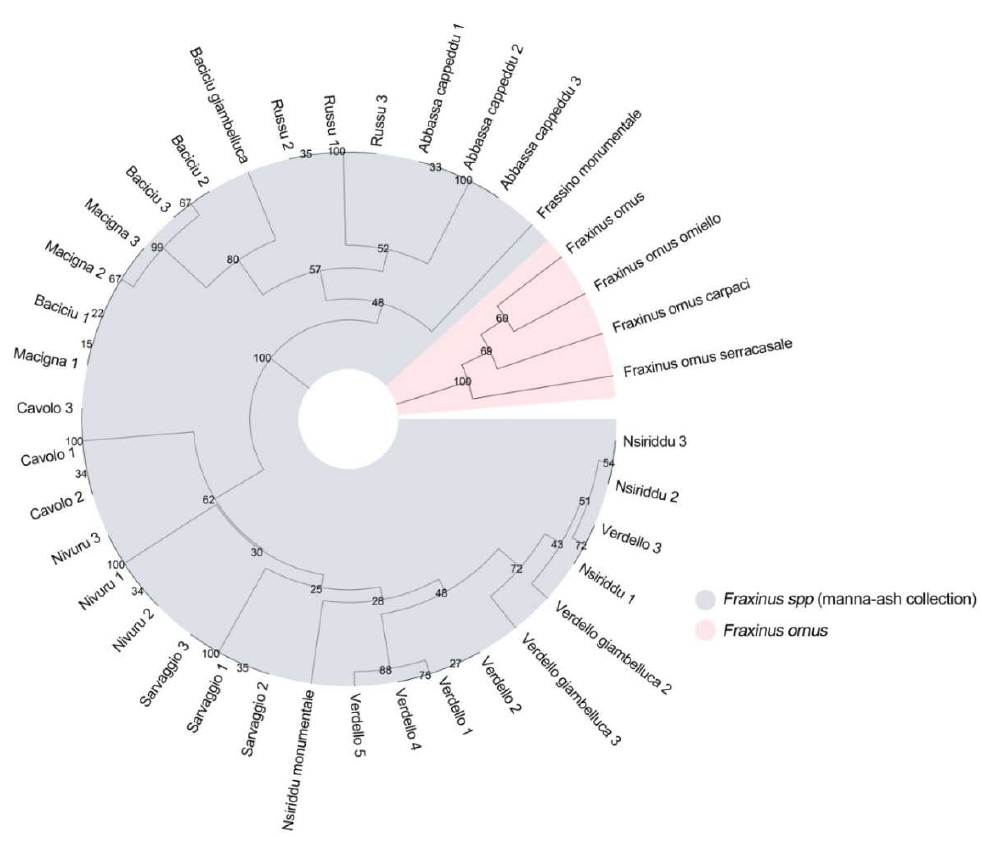
Figure 1. Genetic relationship developed using the profiles obtained from eleven nSSR (Table S2) among studied local varieties (34 samples) collected in Sicily, belonging to the manna ash germplasm. Four genotypes belonging to F. ornus were used as references. The dendrogram was developed using the UPGMA and Bruvo’s distance [51].